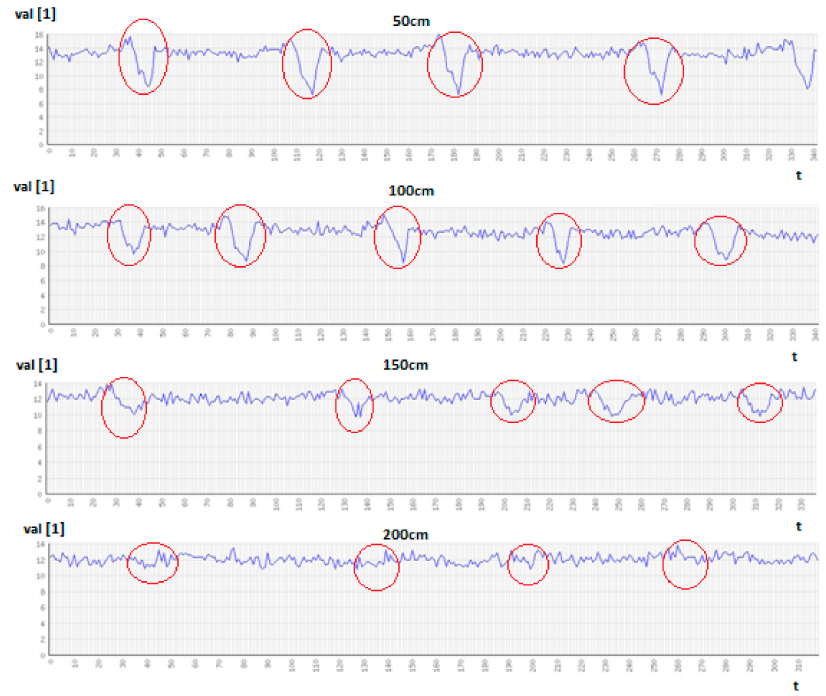
Figure 9. Readings of magnetometer for various distances between vehicle and